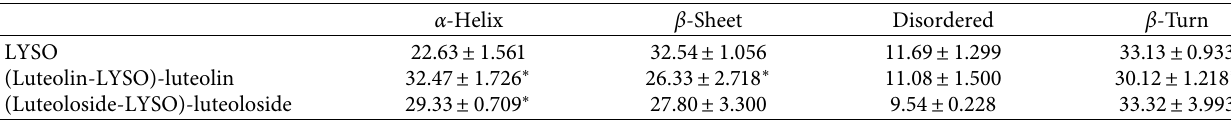
Table 1: The relative contents of lysozyme secondary structure ( n �